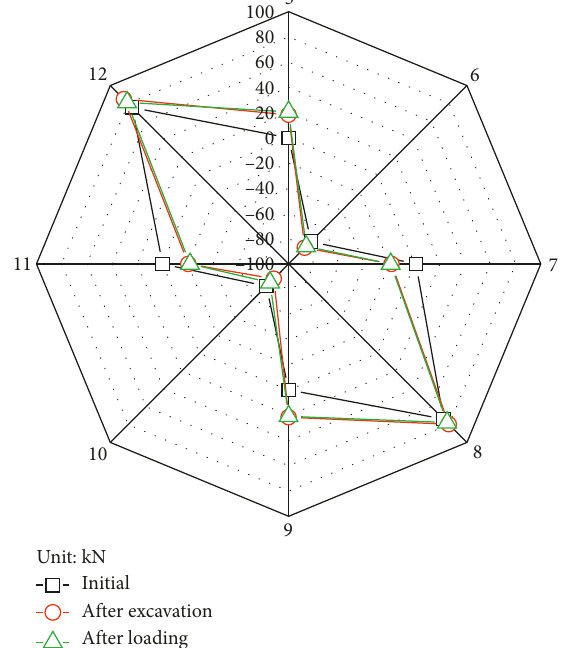
Figure 23: Shear forces of the tunnel structure in scheme 0.